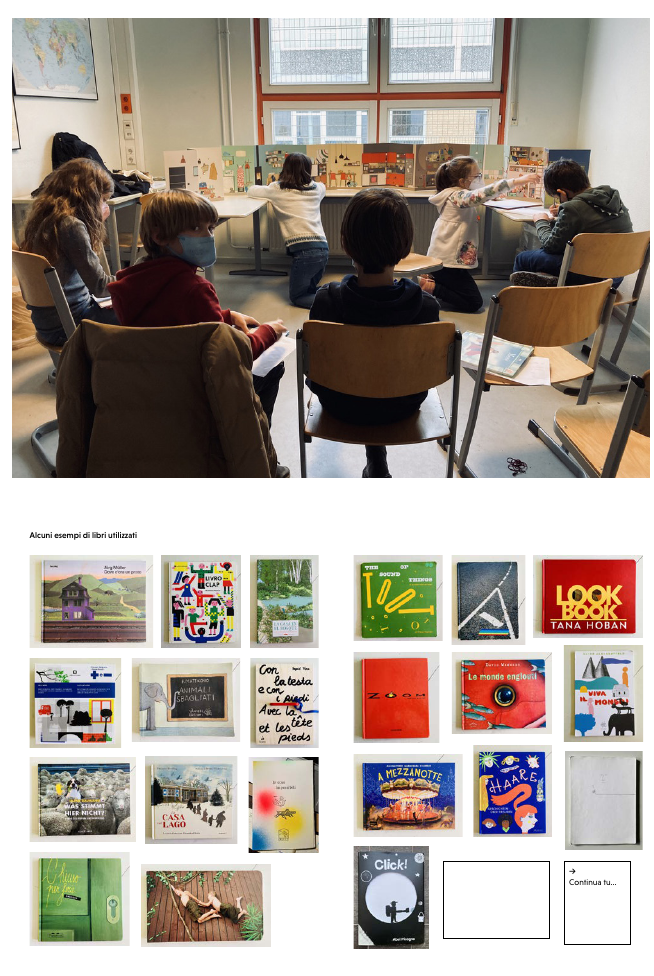
Fig. 1 Photo by Giulia Mirandola.